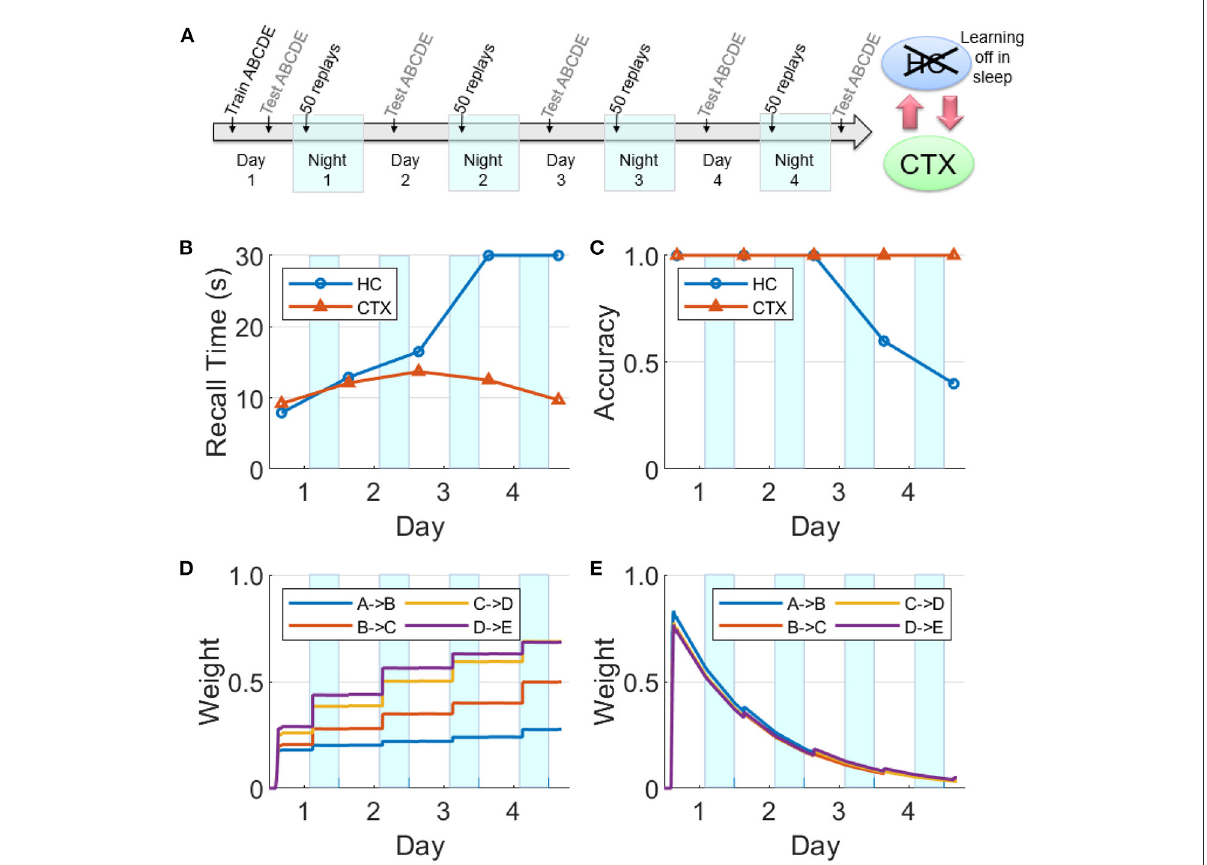
FIGURE11 Intact network with hippocampal learning turned off during sleep. (A) Hippocampal replays occur during sleep, but with learning turned off, the hippocampal weights do not benefit and decay continuously. However, sufficient weight strengths are built up in the cortex during Night 1 such that the cortex is able to sustain replays through the subsequent nights. In this case, the cortex can still consolidate the sequence and become independent of the hippocampus. (B) Recall time, where 30 s is default for incomplete recalls. (C) Recall accuracy. (D) Weight strengths in CTX. (E) Weight strengths in